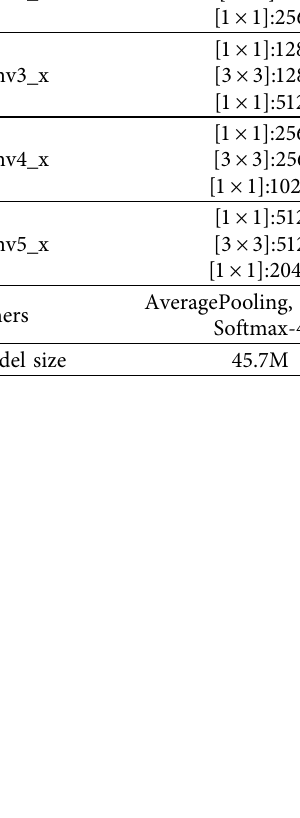
Figure 3: Two basic stacking modes for residual modules. (a) Identity Block. (b) Conv